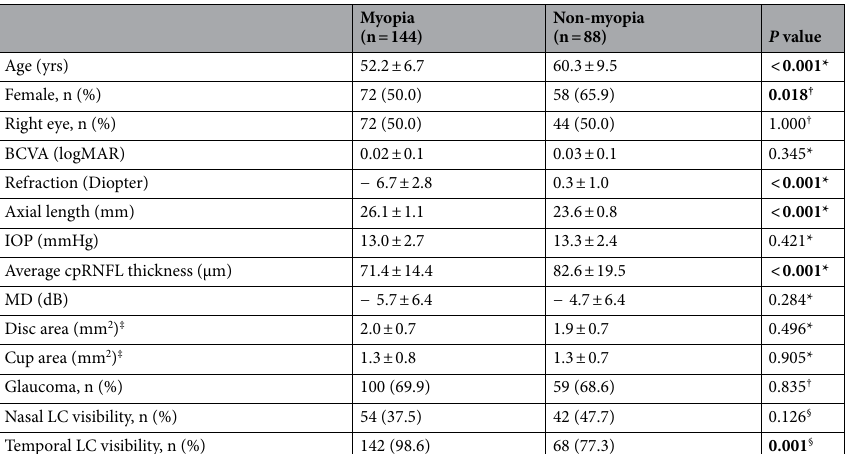
Table 1. Baseline demographics and descriptive characteristics. Except where indicated otherwise, values are mean ± standard deviation or number (%). *Comparison was performed using the Student t test. † Comparison was performed using the two proportion z-test. ‡ Corrected area calculated in consideration of the magnification factors related to the SD-OCT camera and the eye by substituting the subject’s axial length. § Comparison was performed using the chi-squared test. Statistically significant values are shown in bold ( P < 0.05). BCVA: best-corrected visual acuity; cpRNFL: circumpapillary retinal nerve fiber layer; IOP: intraocular pressure; LC: lamina cribrosa; MD: mean deviation.